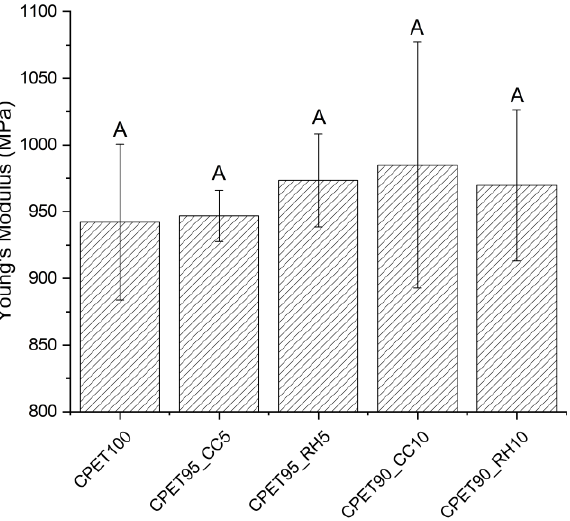
Figure 8. Young’s Modulus for the CPET/biofiller blends. Data points associated with the same letter are statistically equivalent (α = 0.05).